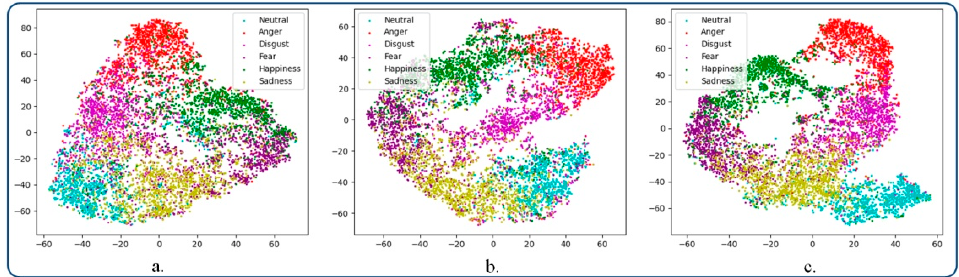
Figure 6. Visualization of the feature embedding using t ‐ SNE on the CREMA ‐ D dataset: ( a ) softmax loss, ( b ) triplet loss, and ( c ) emotion metric learning.